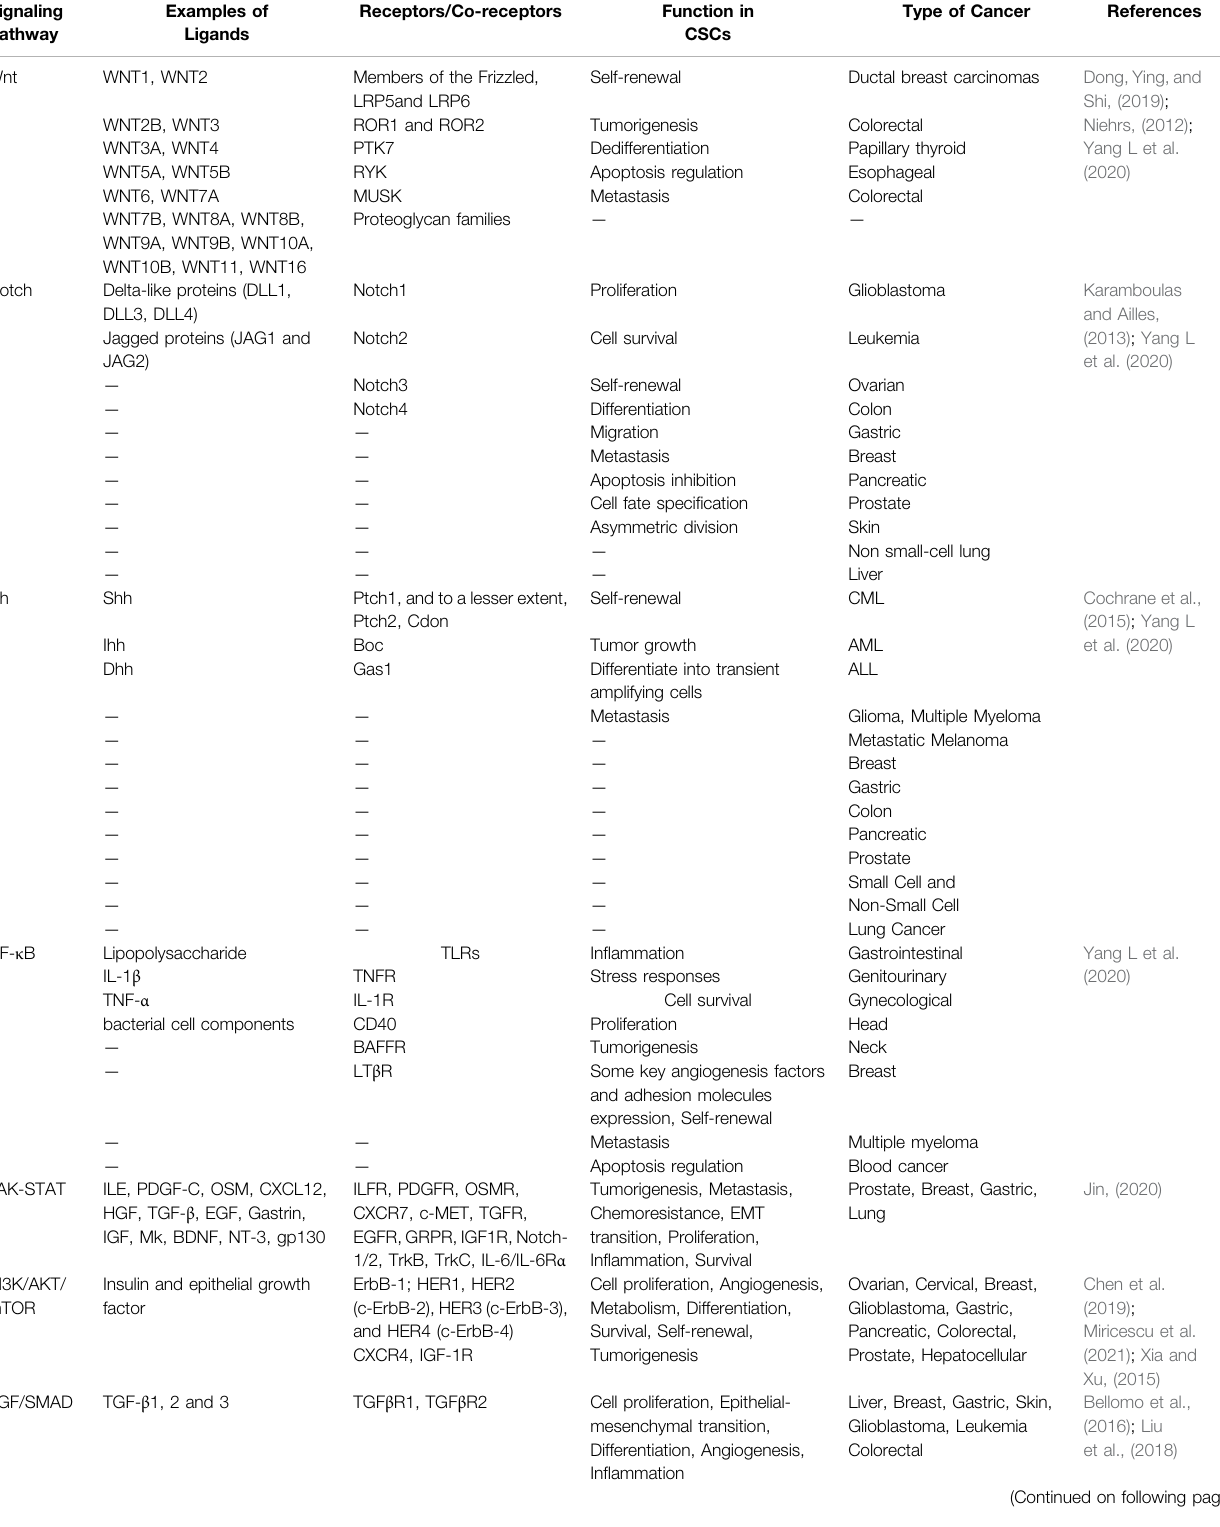
TABLE 2 | CSCs signaling pathways